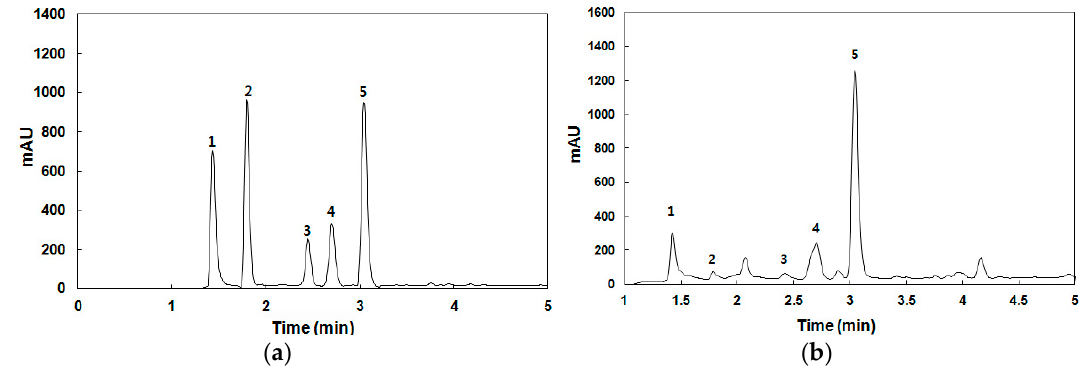
Figure 1. High-performance liquid chromatograms of standards ( a ) and spent coffee extract ( b ) at 258 nm. 1: trigonelline; 2: gallic acid; 3: protocatechuic acid; 4: chlorogenic acid; and 5: caffeine.